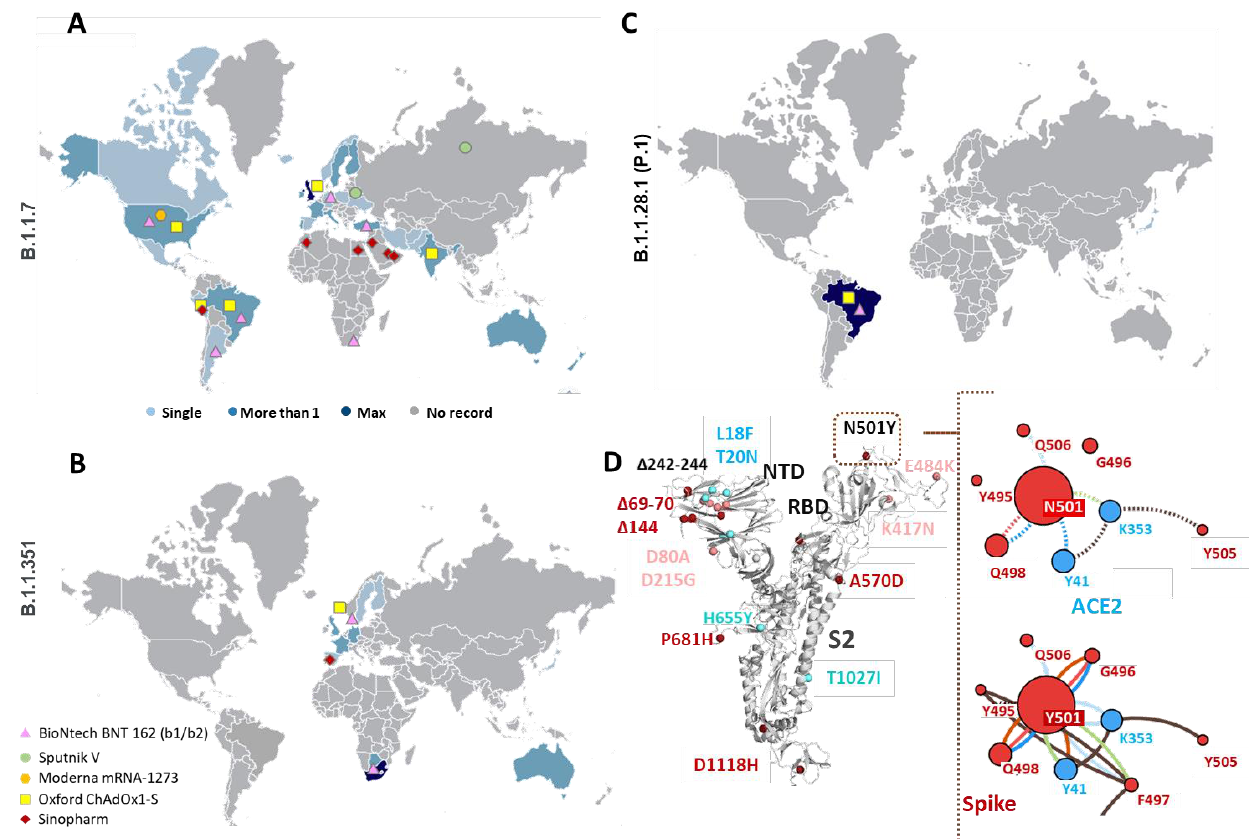
Figure 1. Emergence of new B.1.1.7, B.1.351 and P.1 variant lineages. ( A – C ) Global distribution of sequences arising from various nations reporting 501Y.V1 (B.1.1.7), 501Y.V2 (B.1.351) and P.1 (B.1.1.28.1) variants, respectively. Pinned colored shapes on the map indicate major vaccine trials in various regions around the globe. Geographical pinning of vaccines in regions with rising frequency of variant population indicate the need to re-assess these candidates against new variants. Single (Light Blue), More than 1 (Blue) and Max (Dark Blue) indicate number of sequences of specific variants originating from different nations. ( D ) Structural mapping of mutations from 501Y.V1 (dark red dots) and 501Y.V2 (pink dots) variants on the spike (S) protein of Severe Acute Respiratory Syndrome-Coronavirus 2 (SARS-CoV-2) . The amino acid deletions (Δ marked) in both variants are located in the N-terminal domain (NTD). The common N501Y mutation is located in receptor binding domain (RBD) region which makes contact with host angiotensin II converting enzyme (ACE2) receptors. Residue interactions of N501 (dashed lines) and Y501 (solid lines) with ACE2 (Blue dots) and other residues of the S protein (red dots) are shown in the right panel. Structural analysis of the mutations shows higher interaction network in Y501-ACE2 compared to wildtype N501-ACE2. Color codes — H-bonds (red), polar H-bonds (orange), VdW (light blue), aromatic (light green) and ring – ring interactions (brown).